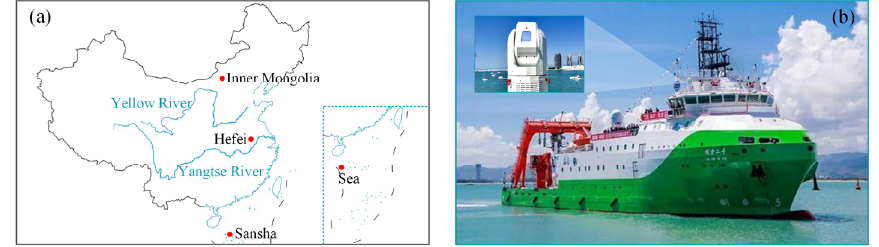
Figure 1. ( a ) Map of the ground-based experiment sites (Inner Mongolia, Hefei, and Sansha) and the ship-borne experiment site (sea). ( b ) Picture of ship-borne CDWL. ship-borne experiment site (sea). ( b ) Picture of ship-borne